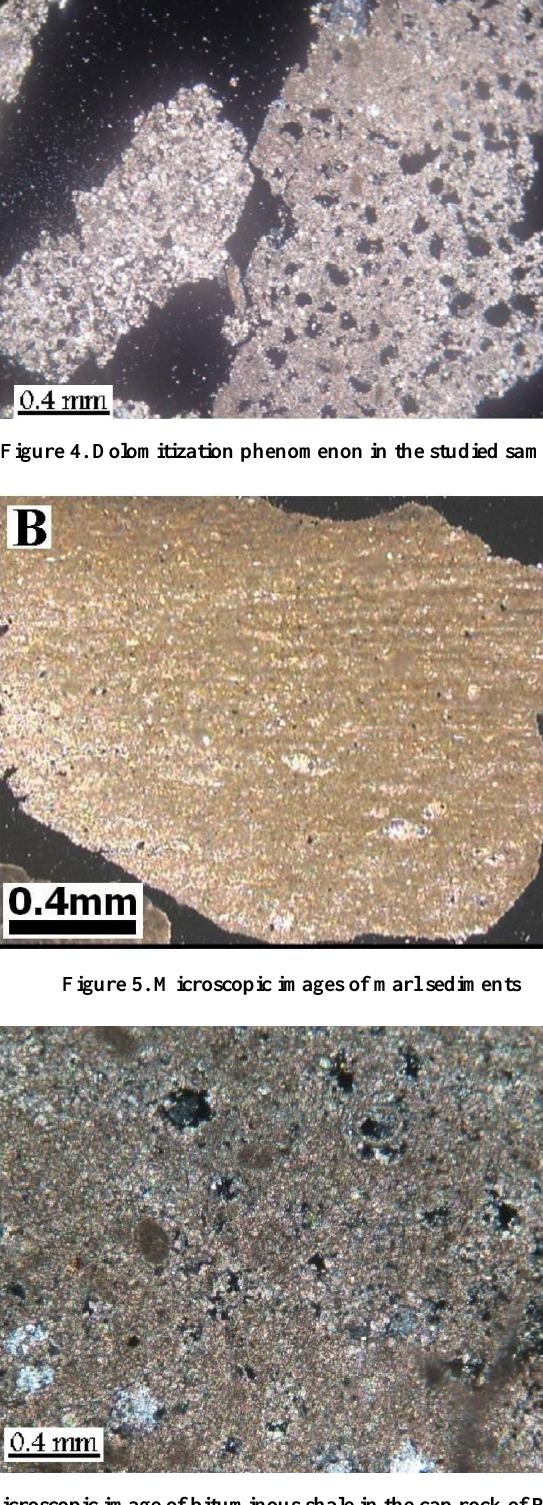
Figure 6. Microscopic image of bituminous shale in the cap rock of Ramshir oil field